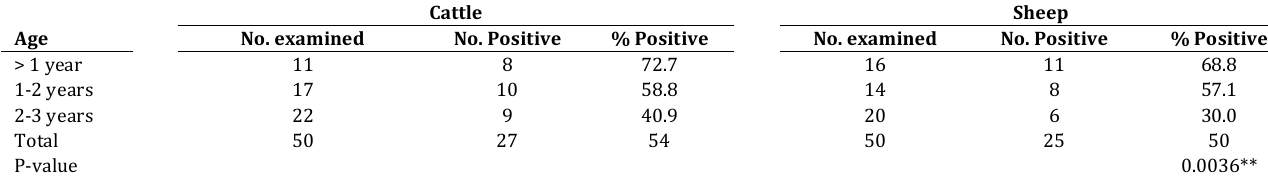
Table 3. Infection rate of Entamoeba spp in cattle and sheep according to age Cattle Sheep